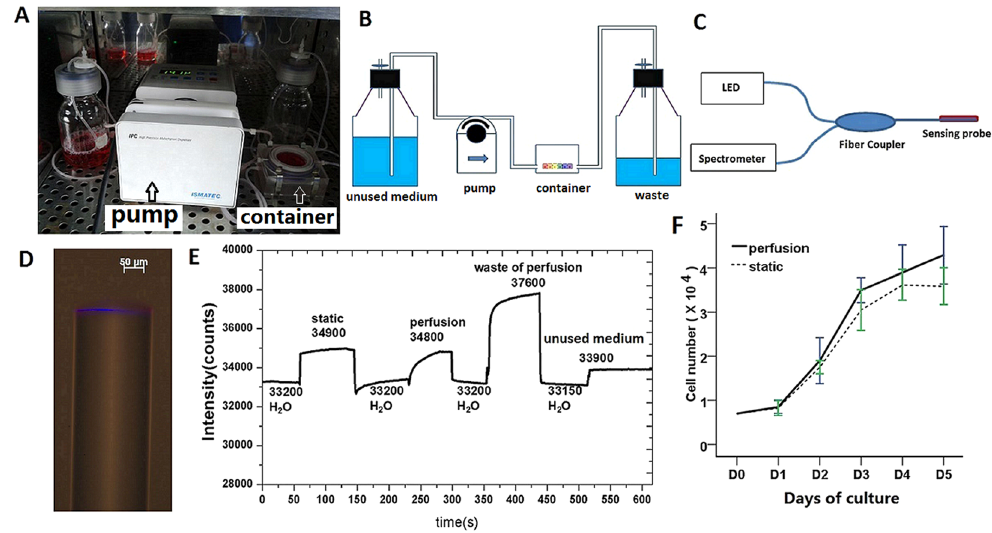
Figure 1. Enhancement of the oxygen supply and CEC proliferation in the perfusion system. ( A ) Photograph of the perfusion system in a 37 °C incubator containing 5% CO 2 . ( B ) Photographic illustration of the perfusion system. ( C ) Schematic of the sensor system. ( D ) Photograph of the microsensor. ( E ) Intensity values of the microsensor for dissolved oxygen. ( F ) Growth curves of CECs in the static and perfusion systems after seeding at an initial cell number of 0.7 × 10 4 cells/well.